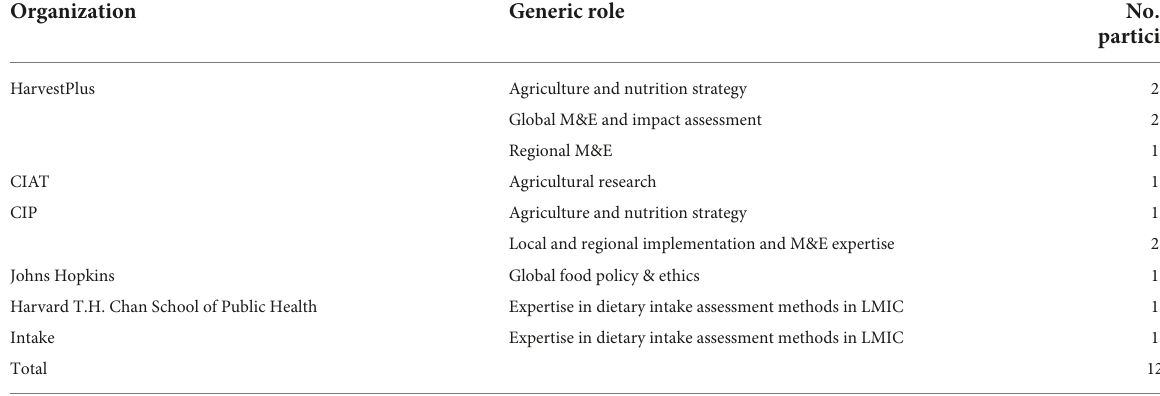
TABLE 2 Characteristics of SSI participants.